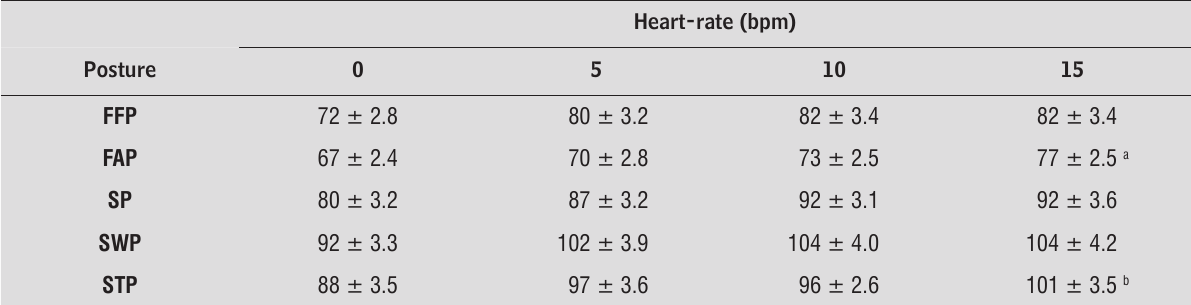
Table 2 - Mean and standard error of the heart rate at: 0, 5, 10, 15 min during the postures frog on the floor (FFP), frog in the air (FAP), sitting (SP), standing against the wall (SWP) and standing with anterior tilt